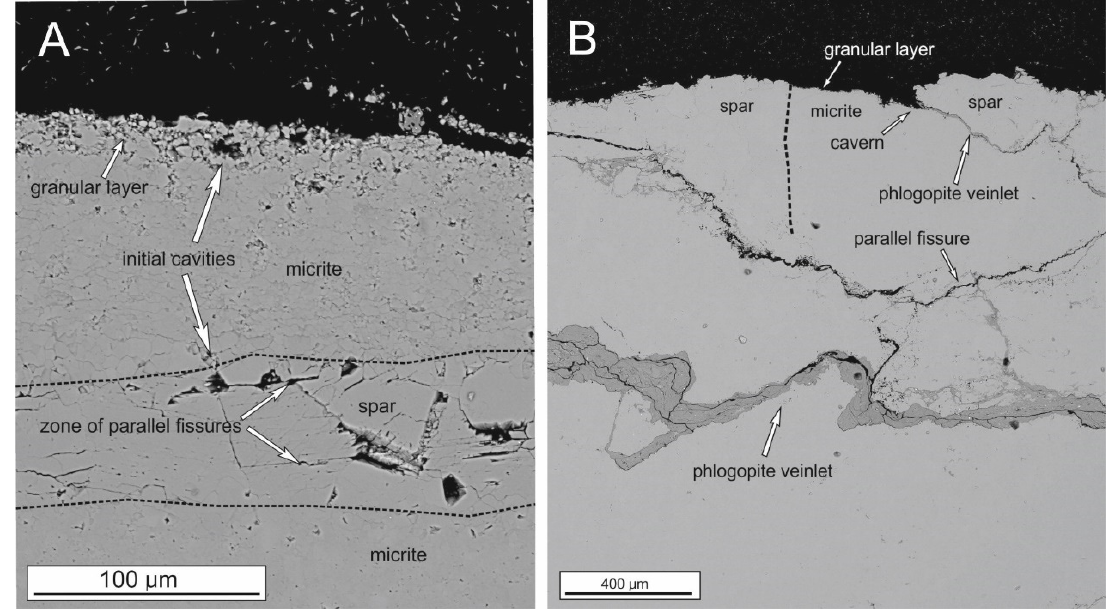
Figure 12. Weathering rind at site 2 (subject to weathering for 10 years); ( A )—spar vein cutting micritic limestone; ( B )—deep fi ssures developed along phlogopite veinlet (images from FE-SEM).